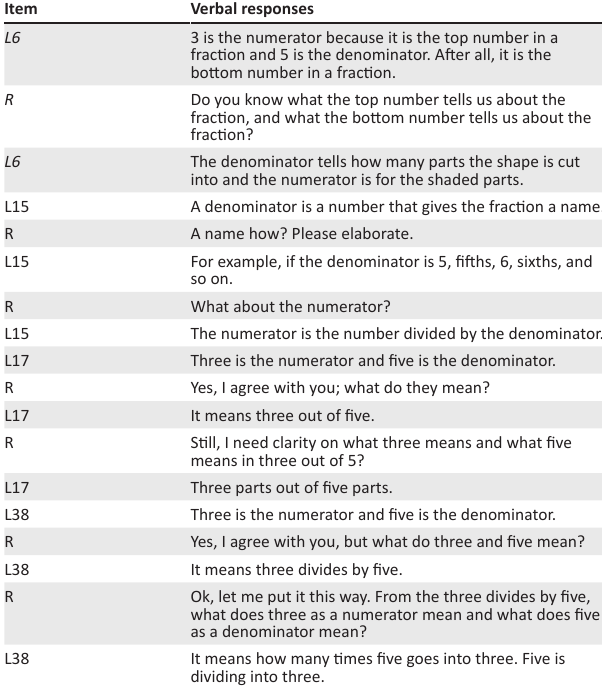
TABLE 10: Verbal response of L6, L13, L15 and L38 on Question 1.3(a) and (b). Item Verbal